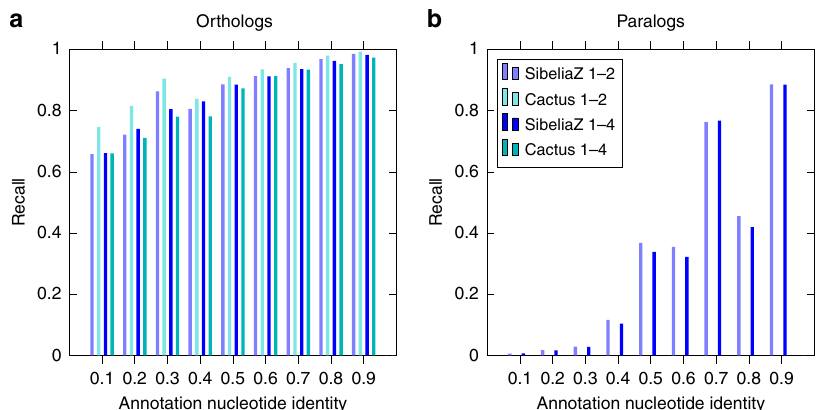
Fig. 4 Recall of nucleotide pairs from homologous genes on the 1-2 and 1-4 mouse datasets. Panels show recall of orthologous ( a ) and paralogous ( b ) nucleotide pairs binned according to the nucleotide identity of their respective genes in the annotation. Recall of paralogs by Cactus is not shown (see text).